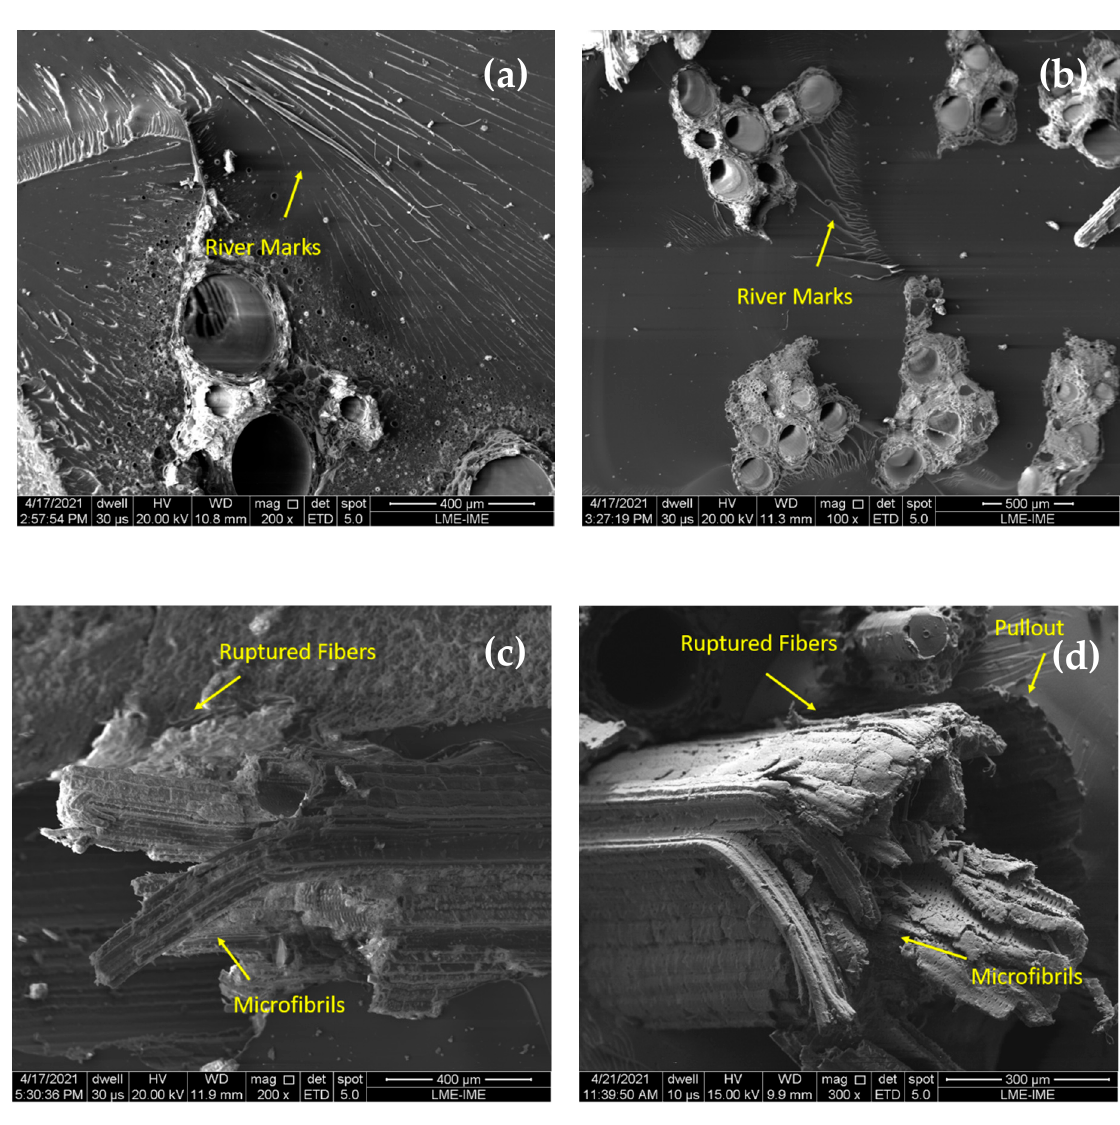
Figure 12. SEM of fracture surfaces of composites incorporated with untreated TVFs after Izod impact tests: ( a ) 10 vol% TVF; ( b ) 20 vol% TVF; ( c ) 30 vol% TVF; and ( d ) 40 vol% TVF.